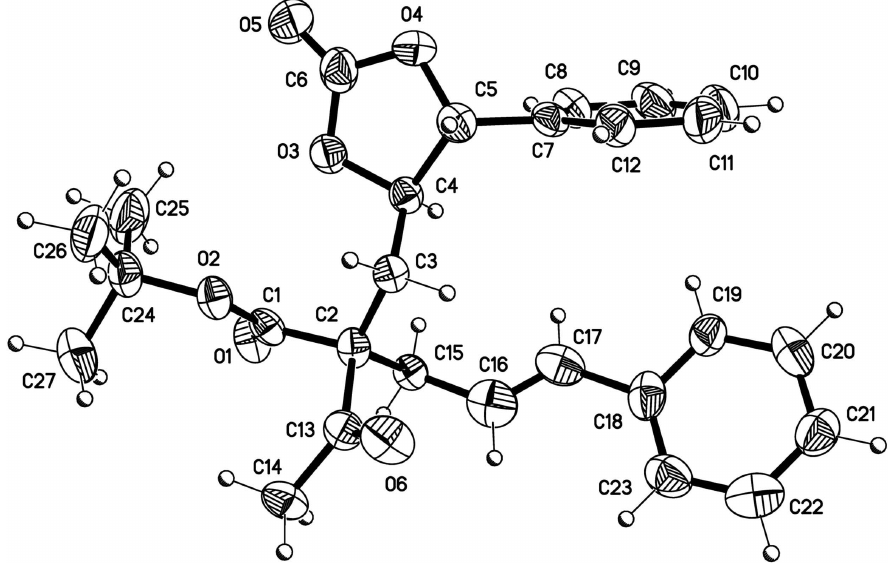
Figure 1 Molecular structure with displacement parameters drawn at the 30% probability level for non-H atoms.